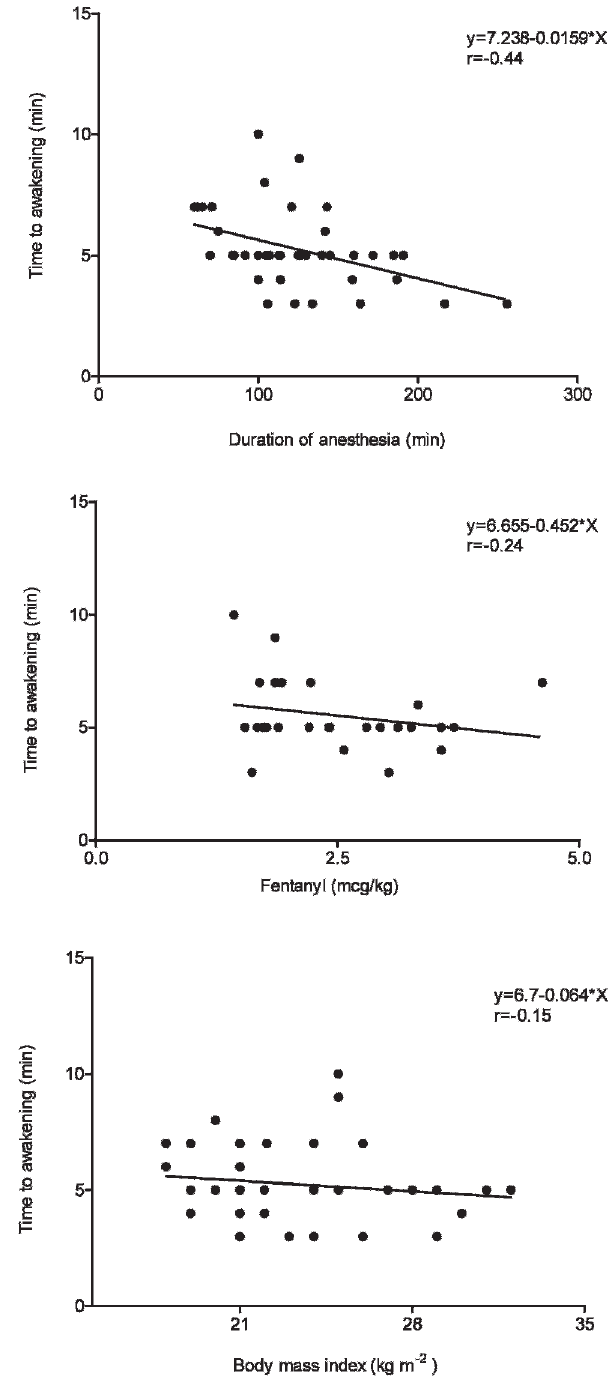
Figure 3 - The time to awakening after discontinuation of 6% desflurane was not prolonged by the duration of anesthesia and was not correlated with the total fentanyl dose or body